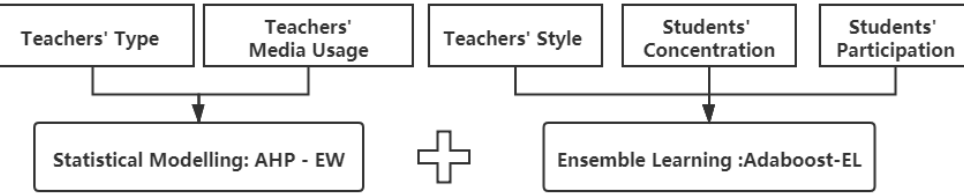
Figure 14. The comprehensive in-class evaluation model.